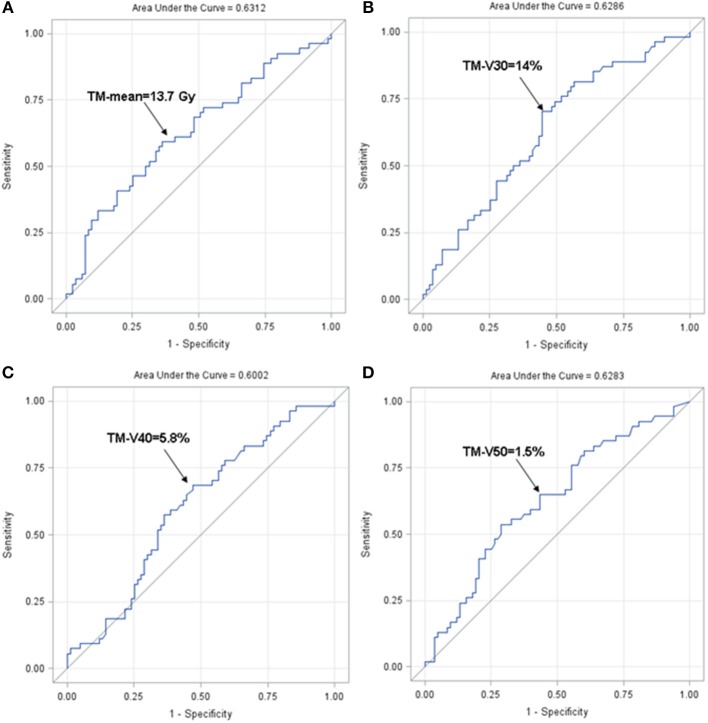
Receiver operating characteristics curve for TM-mean (A), TM-V30 (B), TM-V40 (C), and TM-V50 (D). ROC, receiver operating characteristic.